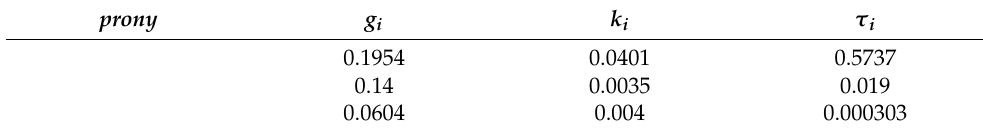
Table 1. Dynamic viscoelastic parameters.